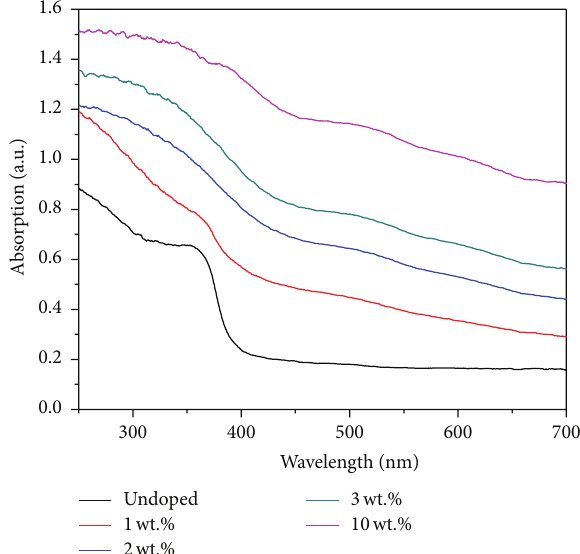
Figure 4: Absorption spectra of undoped and Mn-doped Zn 2 SiO 4 based glass-ceramic sintered at 600 ∘ C.